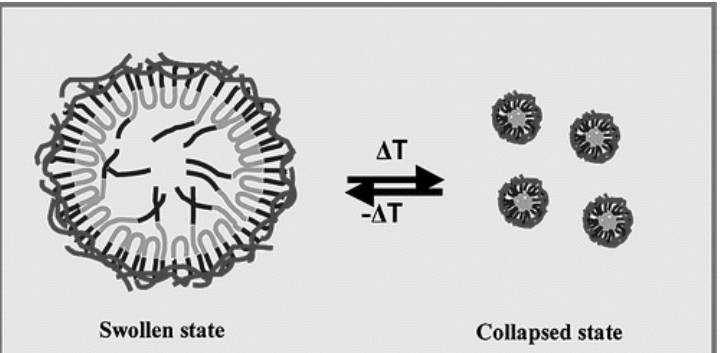
Figure 4. Schematic diagram of Pluronic® F-127 nanocapsules. Reproduced with permission from reference